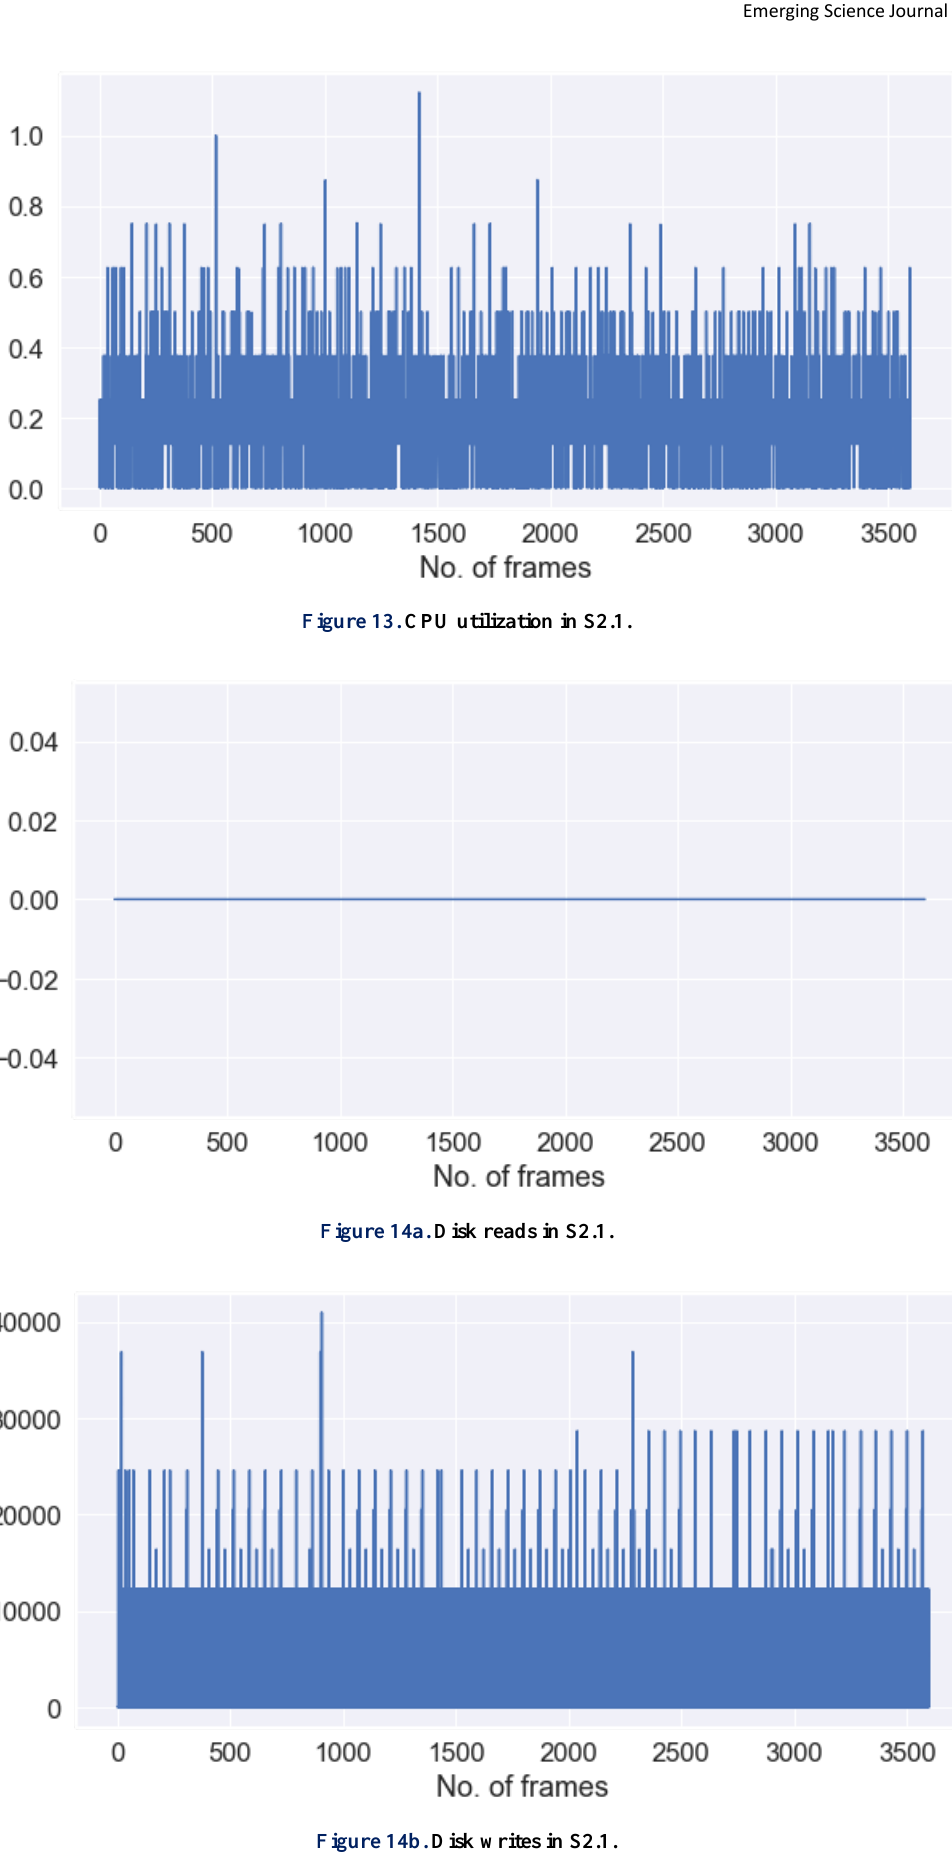
Figure 14b. Disk writes in